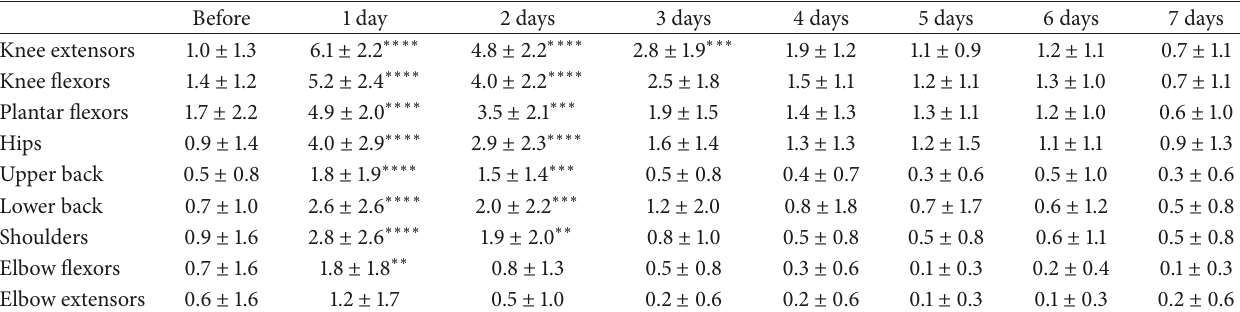
Table 3: Perceived muscle soreness before and for seven days after a marathon race.